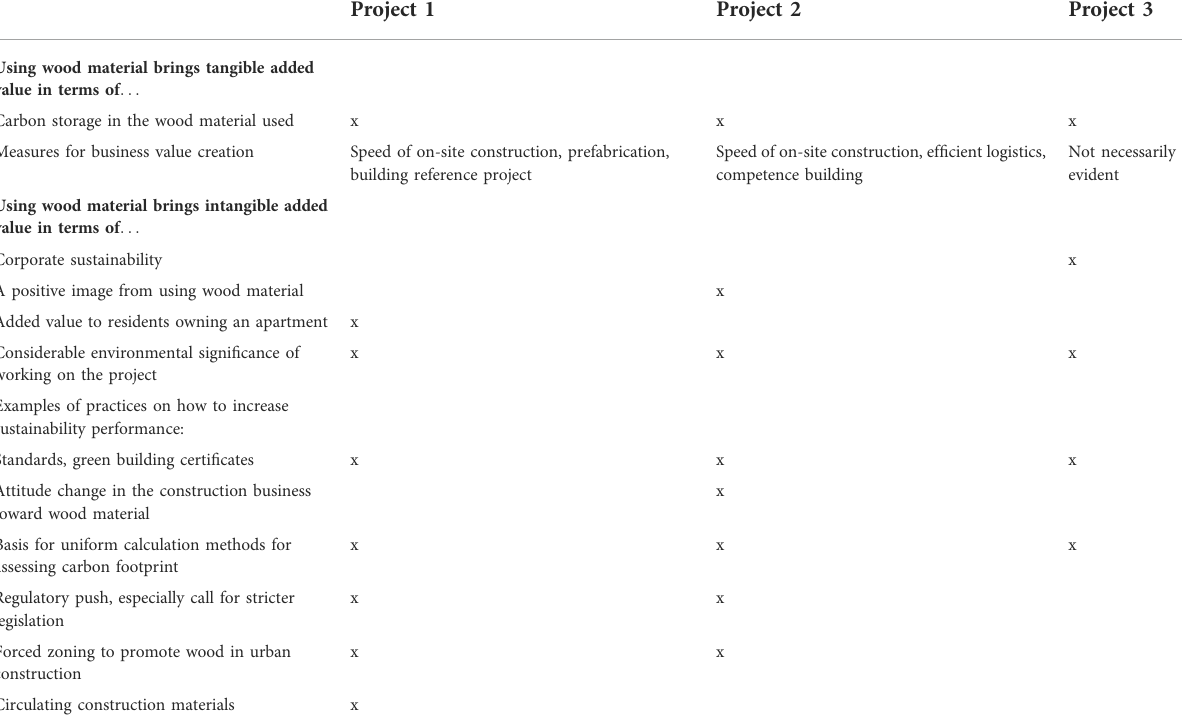
TABLE 2 Perceptions of environmental and other bene fi ts from building with wood arising from three multistory apartment construction (WMC)